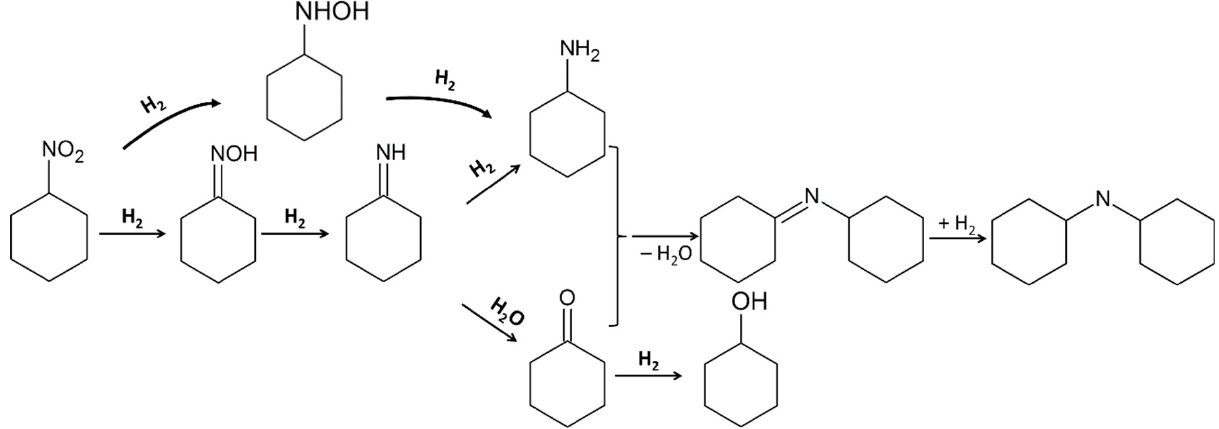
Table 2. Cu/SiO 2 , CuCo/SiO 2 , and Co/SiO 2 physicochemical parameters.